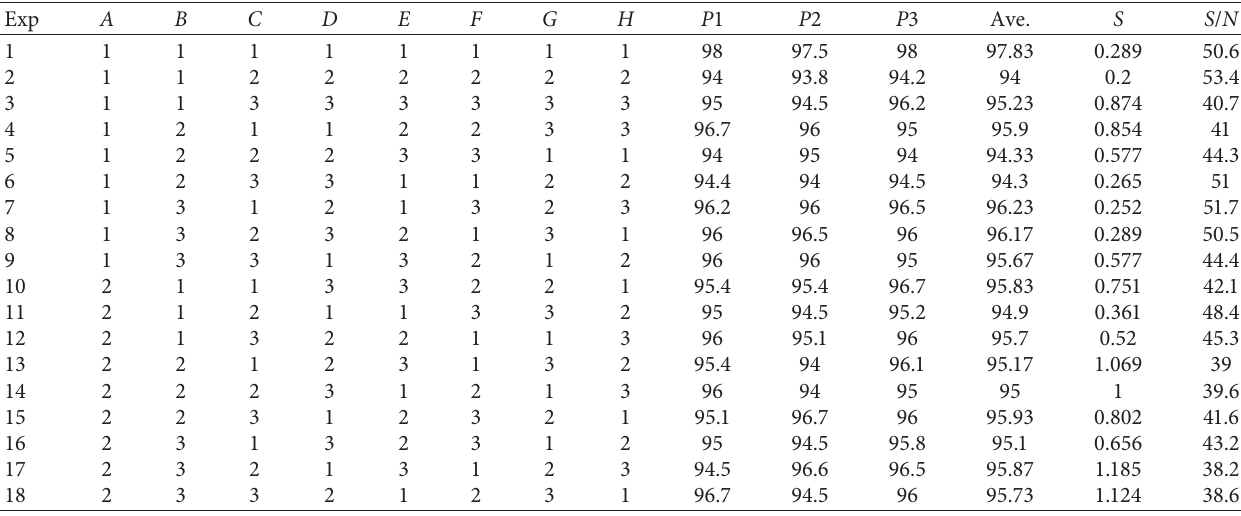
Table 2: Factor reaction